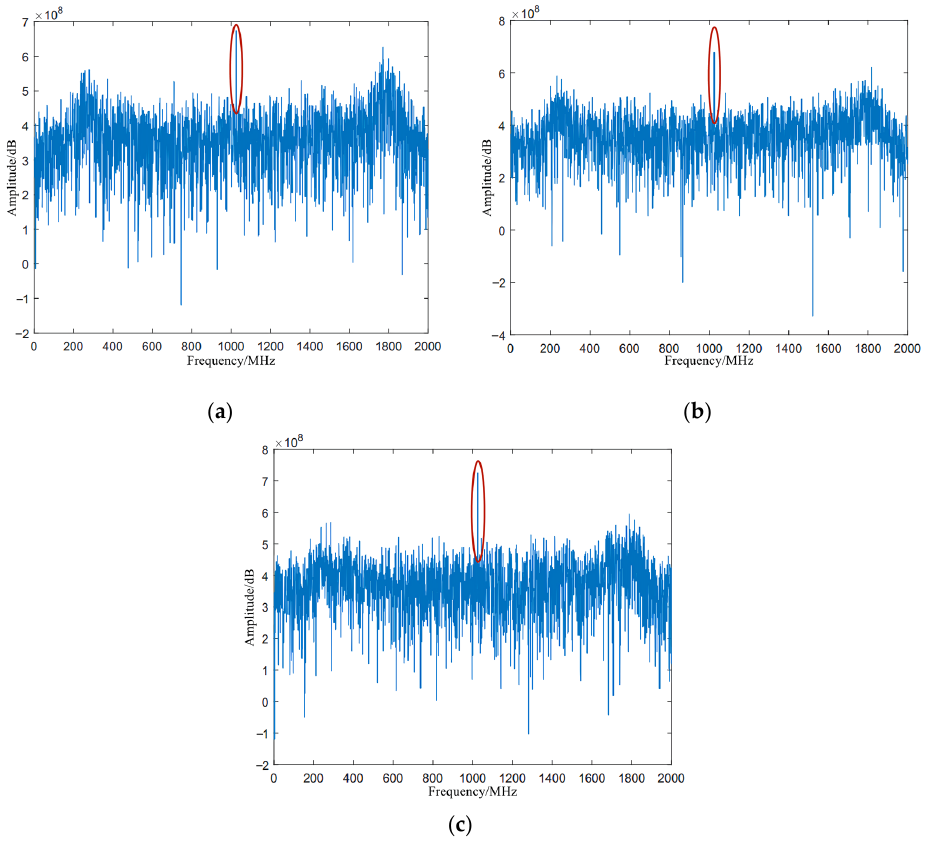
Figure 9. Spectrum processing diagram at three different frequencies: ( a ) spectrogram when the frequency of the input signal is 4780 MHz; ( b ) spectrogram when the frequency of the input signal is 4820 MHz; and ( c ) spectrogram when the frequency of the input signal is 4900 MHz. According to the above test method, the frequency of the input signals are 4780 MHz, 4820 MHz, and 4900 MHz, respectively, corresponding to (a), (b), and (c) of Figure 9. Ad- ditionally, the results of spectral processing are also clearly visible. Since the spectrum of